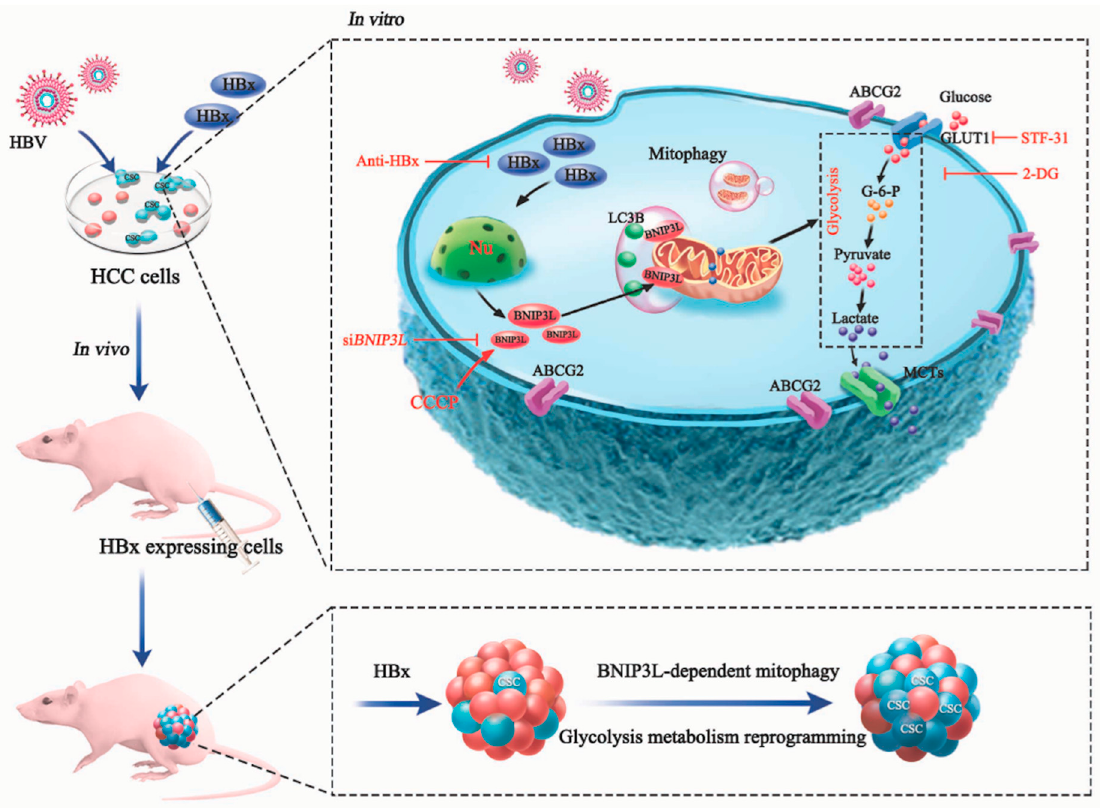
Figure 9. The scheme for molecular mechanisms of BNIP3L-dependent mitophagy-mediated reprogramming of glycolytic metabolism promoted cancer stemness in HBx-expressing HCC cells. In vivo, HBx-expressing promoted xenografted tumor growth, upregulated the expression of